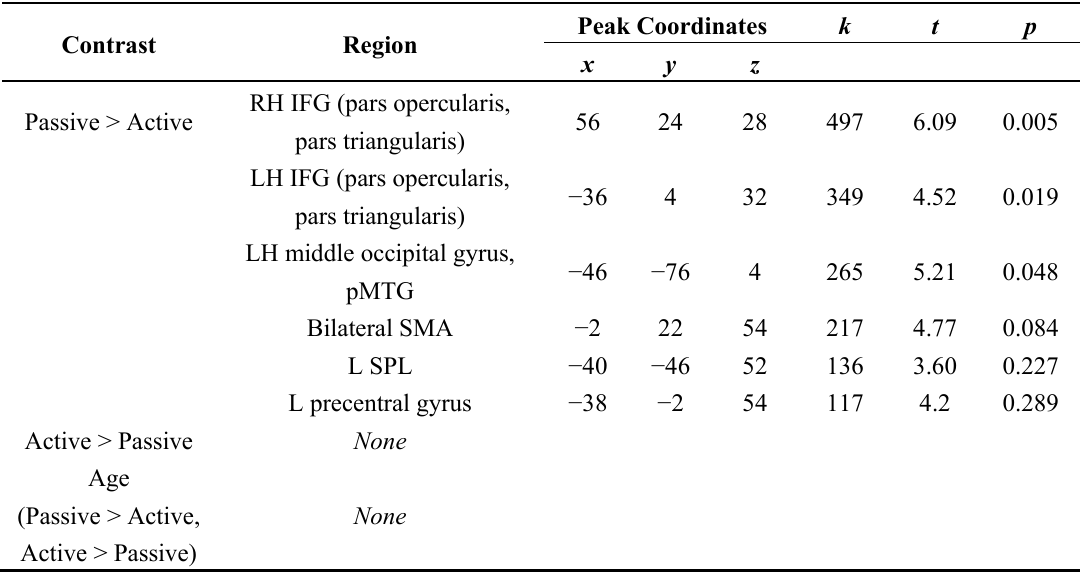
Table 1. Areas of differential activation for passive and active sentences. Peak Montreal Neurological Institute (MNI) coordinates, cluster sizes ( k ), maximal t- values, and cluster-corrected (family-wise error rate) p- values are reported (voxel-wise threshold of p < 0.001, uncorrected, k ≥ 85). Notes: LH, left hemisphere; RH, right hemisphere; IFG, inferior frontal gyrus; pMTG, posterior middle temporal gyrus; SMA, supplementary motor area; SPL, superior parietal